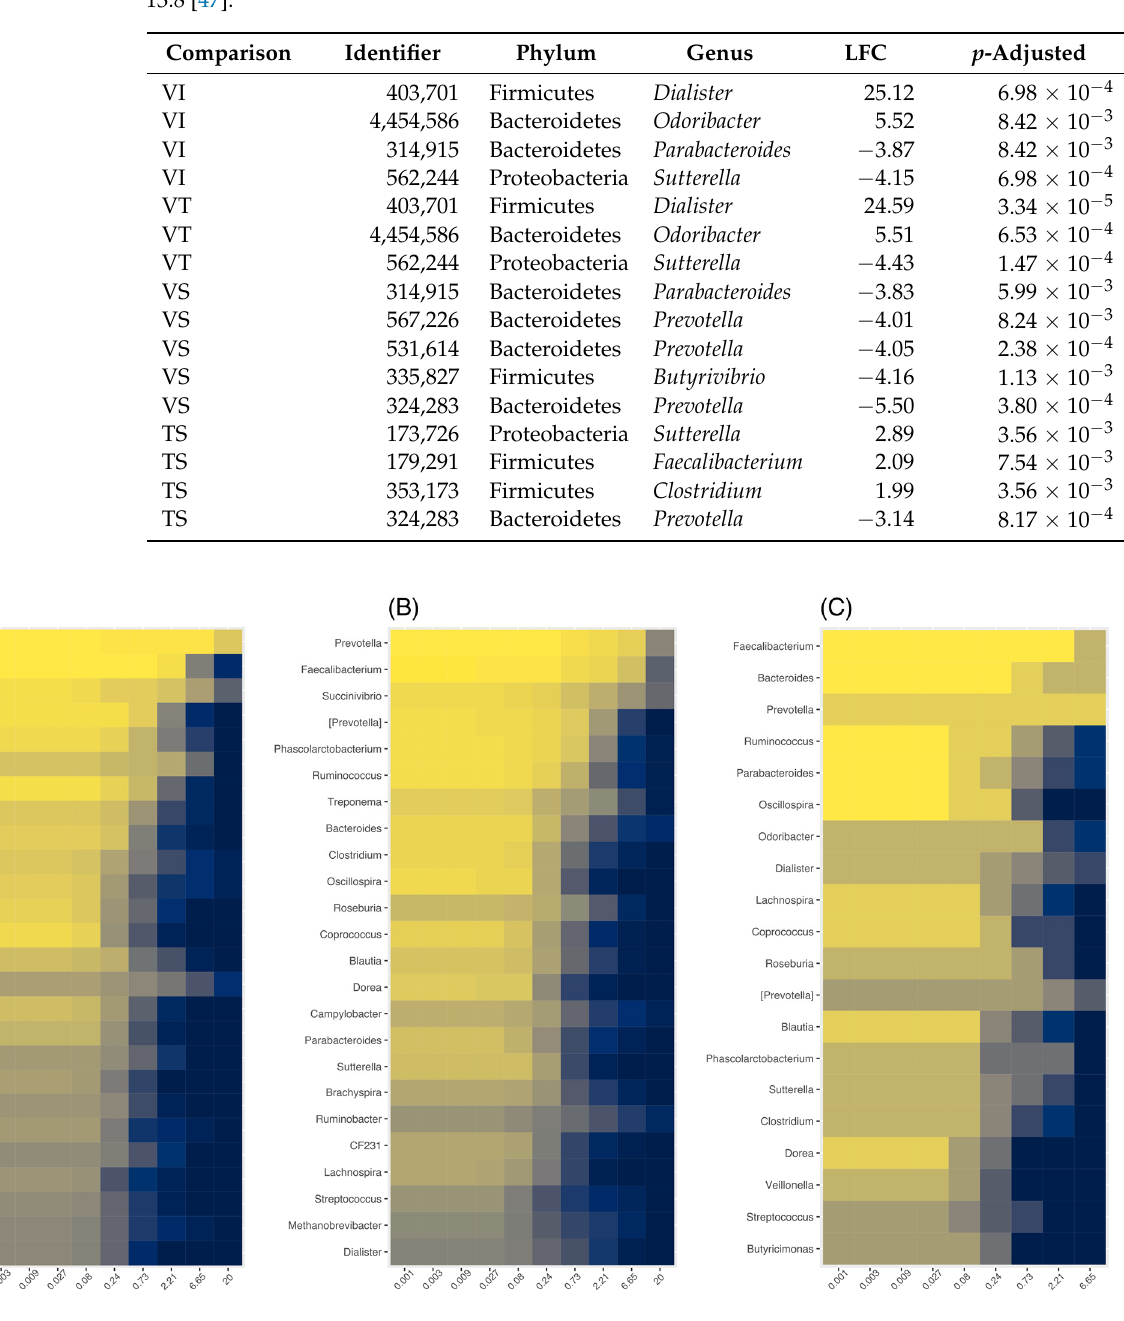
Table 1. Differentially abundant taxa from the comparison between the different population groups. Comparison specifies the pair analyzed: Valledupar vs. Indigenous (VI), Valledupar vs. Tezhumake (VT), Valledupar vs. Siminke (VS), and Tezhumake vs. Siminke (TS). LFC indicates the Log2-fold changes between both sample groups, and the adjusted p -value was calculated with the Benjamin– Hochberg method to control the False Discovery Rate (FDR < 0.1), as implemented in the DESeq2 R library [39]. The OTU identifiers correspond to those pertaining to the Greengenes database, version